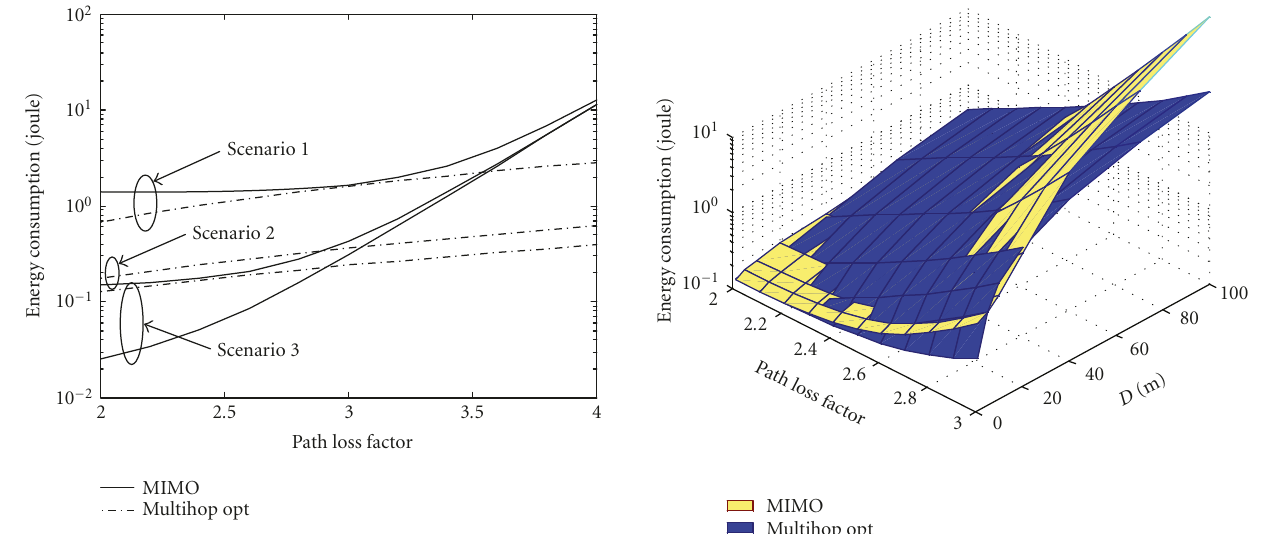
Figure 5: Total energy consumption versus n when ρ s = 0 . 01 ( M = 100) and D = 40m.